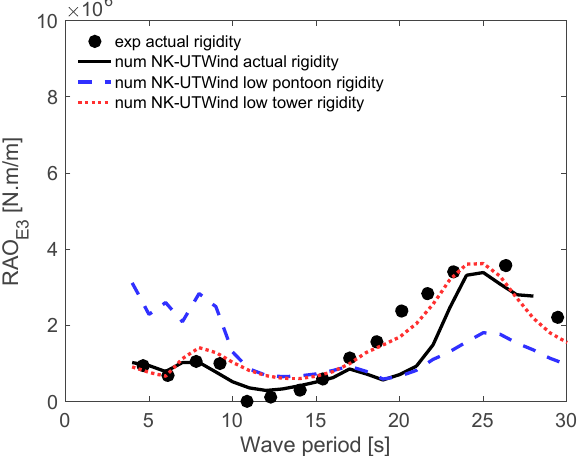
Figure21. InfluenceofthetowerandpontoonrigiditiesontheRAObendingmomentattheside-pontoon Figure 21. Influence of the tower and pontoon rigidities on the RAO bending moment at the side- J. Mar. Sci. Eng. 2020 , 8 , x FOR PEER REVIEW gage (A3), and its comparison between the experiment and calculation. pontoon gage (A3), and its comparison between the experiment and calculation.